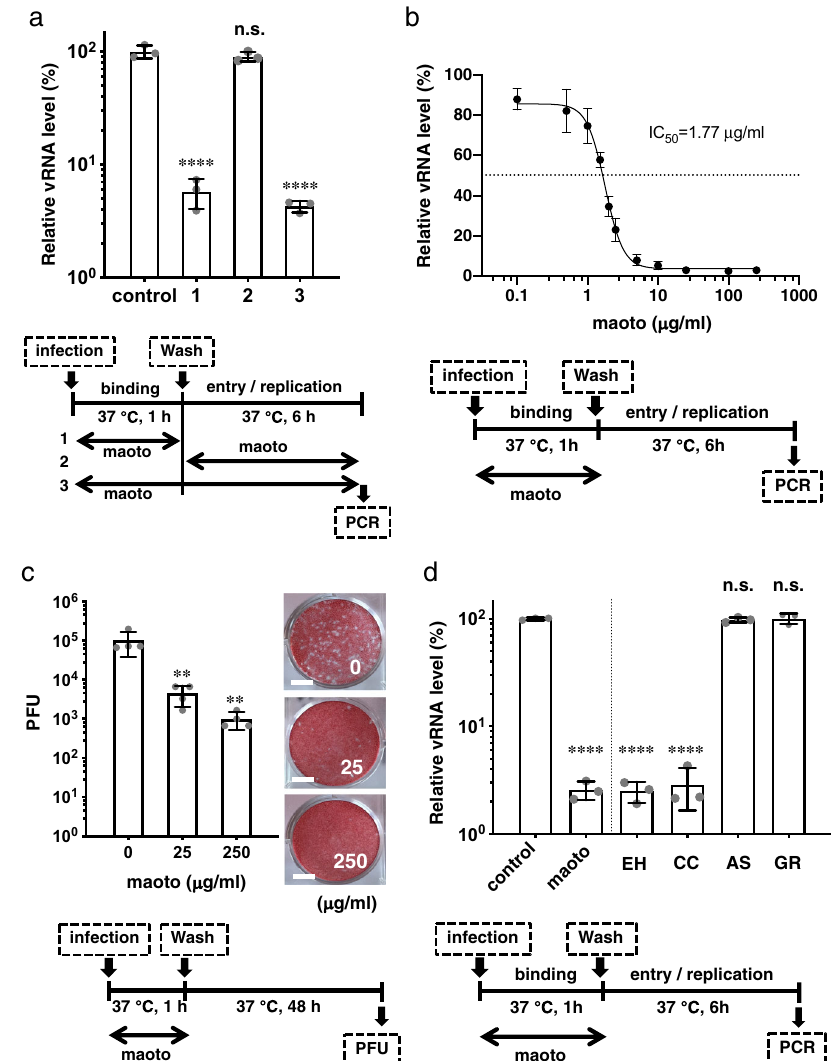
Fig. 1 Anti-RSV activity of maoto in cultured cells in the early phase of the viral life cycle. a Anti-RSV activity of maoto in A549 cells. A549 cells were infected with RSV-A (multiplicity of infection [moi] 1) and treated with maoto (25 µ g/mL) at the binding phase (1), entry/replication phase (2), and both (3), followed by culture for six hours. Viral RNA (vRNA) in the cells was quanti fi ed by RT-PCR. The culture condition was illustrated bellow. b Dose- dependent decrease of vRNA by maoto. A measure of IC50 was determined using logistic regression testing. The culture conditions are illustrated bellow. c Production of infectious progeny viruses was inhibited by maoto. A549 cells were infected with RSV in the presence or absence of maoto at the binding phase, and then cultured for 48 h. Viral titers in supernatants were determined by plaque forming assay. Scale bars indicate 5 mm. d Herbal components of maoto that block the infectivity of RSV. EH; Ephedrae Herba (7.5 µ g/mL), CC; Cinnamomi Cortex (7.5 µ g/mL), AS; Armeniacae Semen (7.5 µ g/mL), GR; Glycyrrhize Radix (2.5 µ g/mL). a – d show individual values and mean±error bars SD ( a , d : n = 3, b , c : n = 4). One-way ANOVA followed by Dunnett post- test. ** P < 0.01, **** P < 0.0001, and n.s.; not signi fi